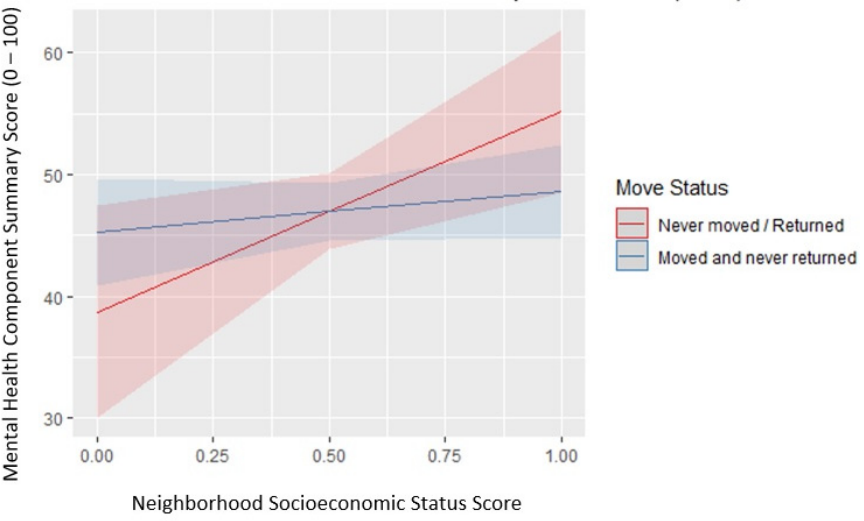
Figure 2. The effects of neighborhood socioeconomic status score on predicted values of mental health scores by move status.